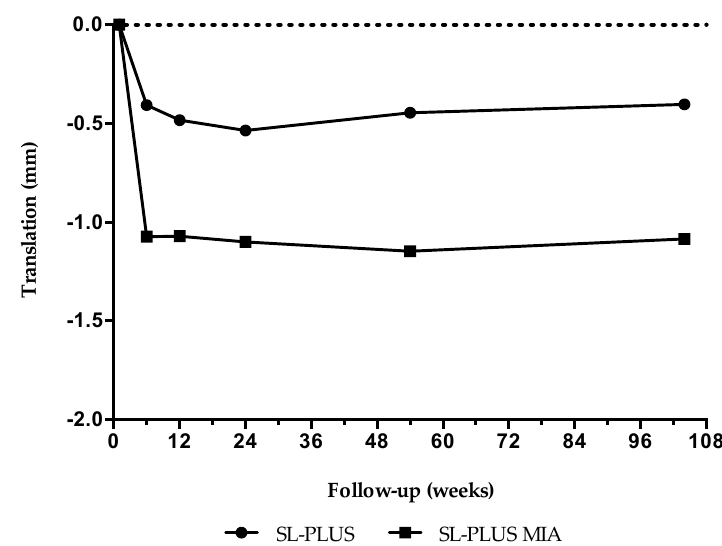
Figure 3. Mean values of stem subsidence (translation along the stem axis) for both femoral components at each follow-up interval. After initial settling within the first 6 weeks no further significant subsidence was noticed for both stem designs.